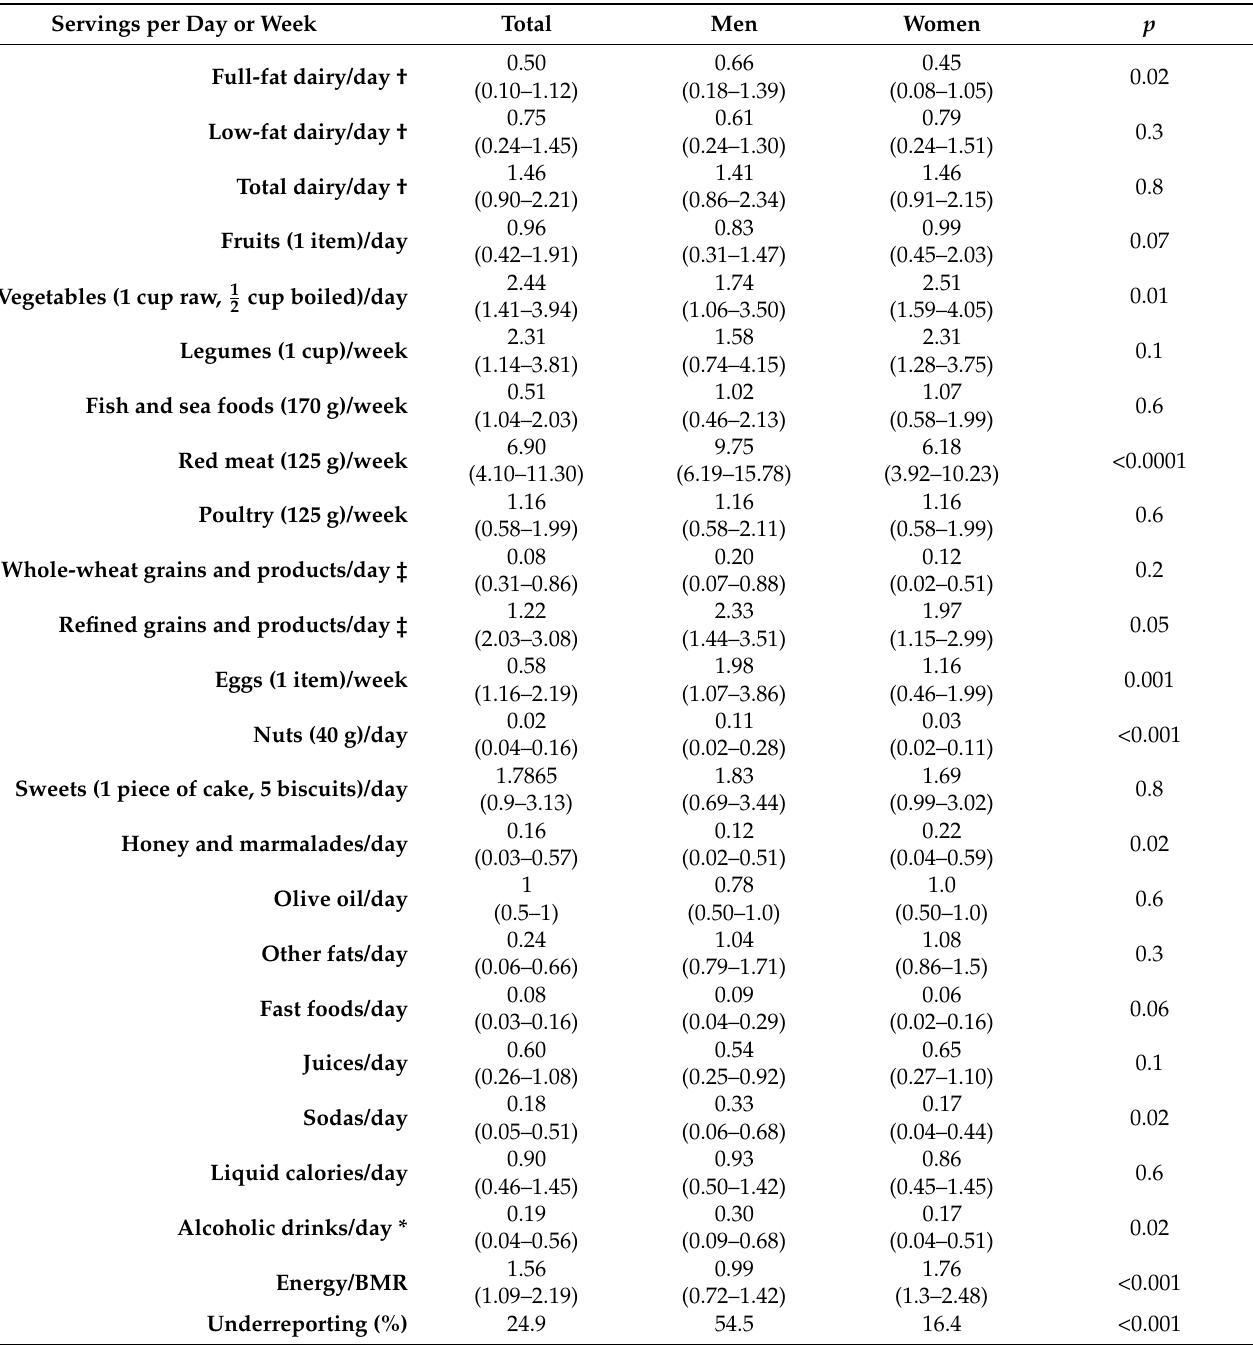
Table 2. Dietary intake of the